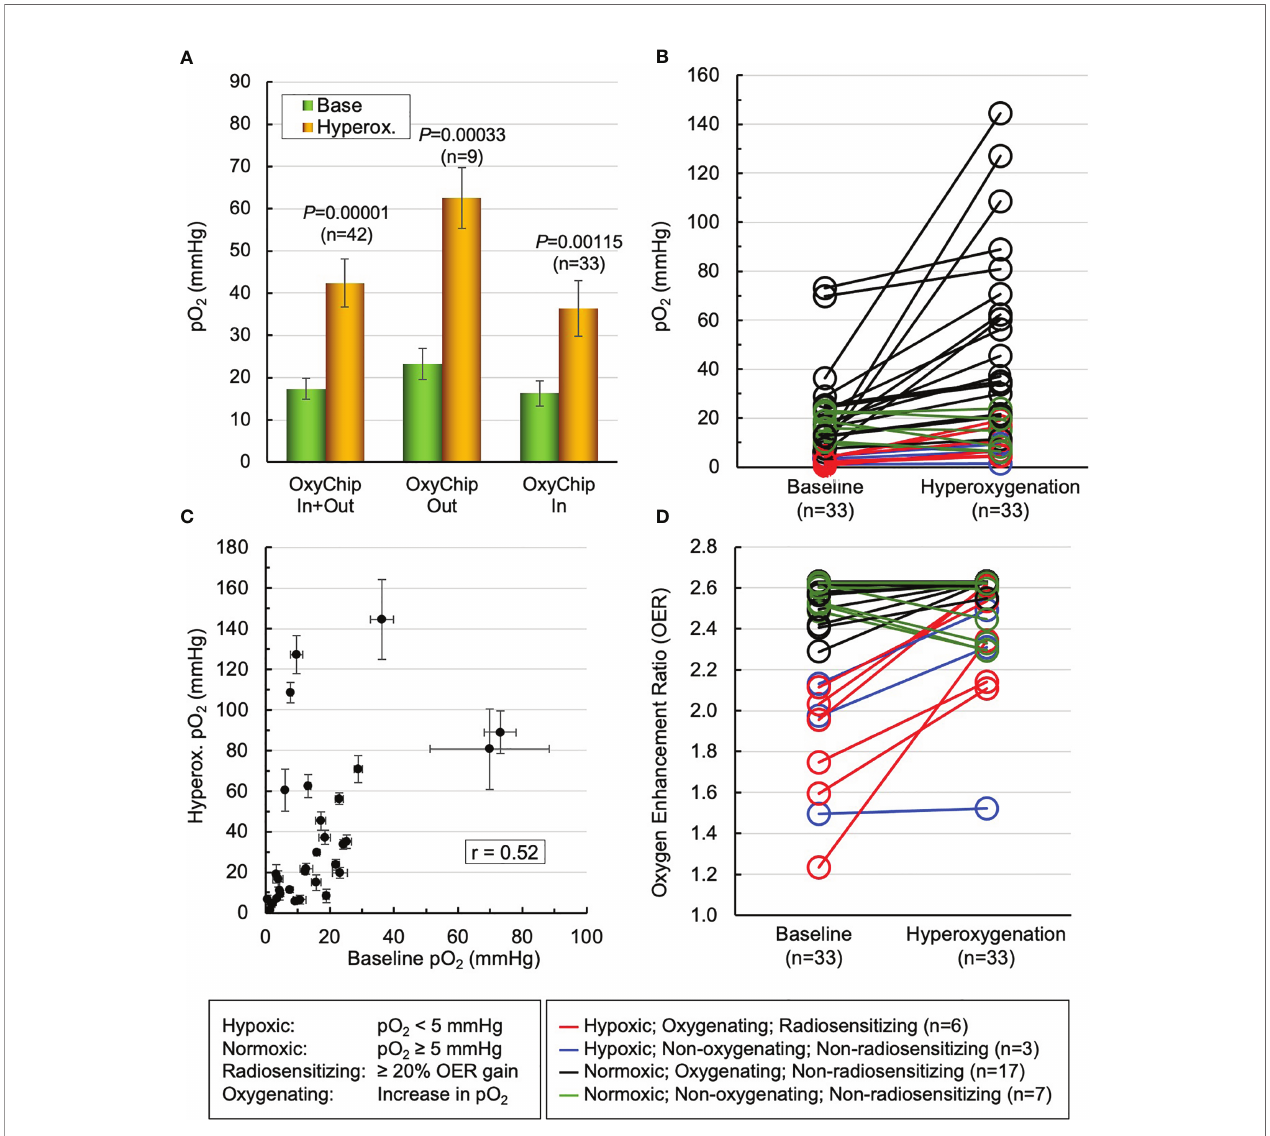
FIGURE 5 | Mitigation of tumor hypoxia for therapeutic enhancement. The pO 2 data from 33 measurements in 12 patients (patients 2 – 5, 9, 11, 12, 19 – 21, 23, 24), wherein the OxyChips were found inside the tumor in the resected specimen or placed in the tumor during ultrasound-guided implantation but unable to ascertain their location after neoadjuvant treatment, were used to identify the population of hypoxic tumors and responders to hyperoxygen intervention. (A) The fi rst pair of bars give the values for the measurements in all malignant tumors. The second and third pairs show the measurements for the malignant tumors in which the OxyChip was or was not found to be in the tumors at the time of resection. Within the third selected group of patients the mean of base pO 2 values was 16.3 ± 2.9 mmHg, while that of hyperoxygen pO 2 values was 36.4 ± 6.6 mmHg ( P =0.00115). (B) A pair-wise representation of the base and hyperoxygen pO 2 values in the 33 measurements in which the OxyChip was in the tumor. (C) Correlation between the baseline pO 2 and its response to hyperoxygenation in the measurements in these selected tumors, exhibiting a moderate correlation (Pearson ’ s correlation coef fi cient r =0.52). (D) Level of radio-sensitization, in terms of oxygen enhancement ratio (OER), by hyperoxygenation. Nine measurements showed severely hypoxic (pO 2 < 5 mmHg) tumors in which six could be sensitized to radiation (i.e., showed ≥ 5 mmHg and, irrespective of whether they responded or not, hyperoxygenation probably would not have ≥ 20% OER gain). Twenty-four measurements had pO 2 had a bene fi cial radio-sensitizing effect in these tumors at the times